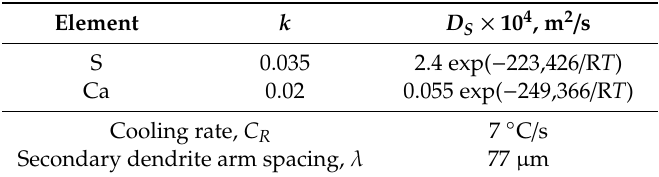
Table 5. Conditions for the calculation of CaS formation